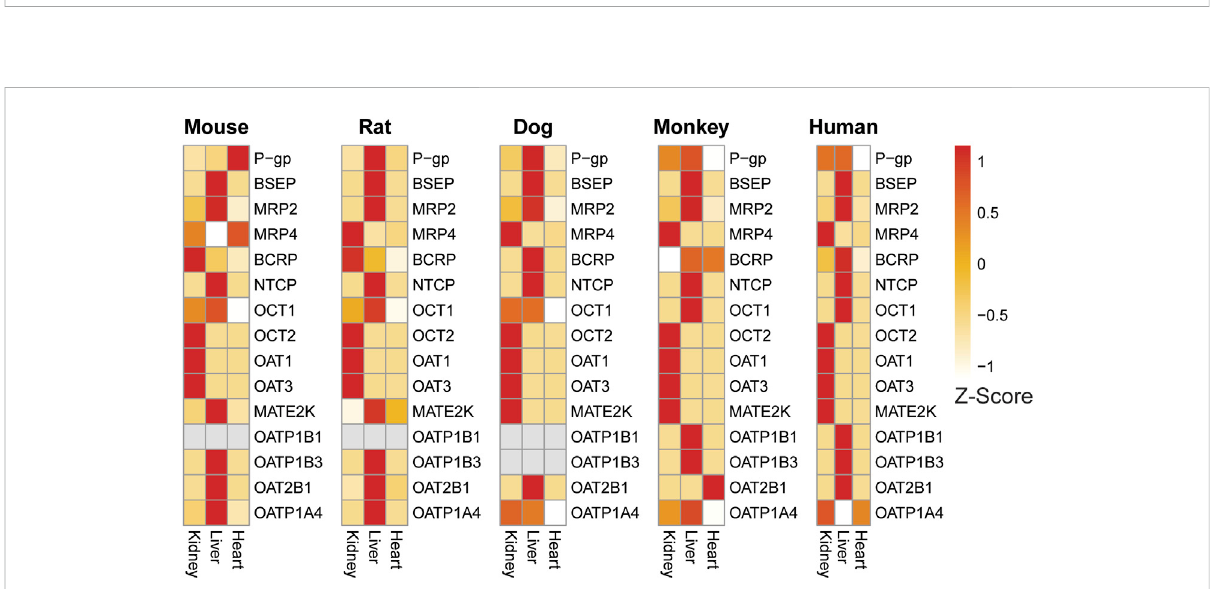
FIGURE 8 Expression heat map of key transporters in the liver, kidney, and heart of male preclinical species and humans con fi rms tissue-speci fi c expression of liver and kidney transporters across species. Heart was included as a general negative control as few transporters are reported to be highly expressed there. Expression patterns are generally consistent across species with some notable